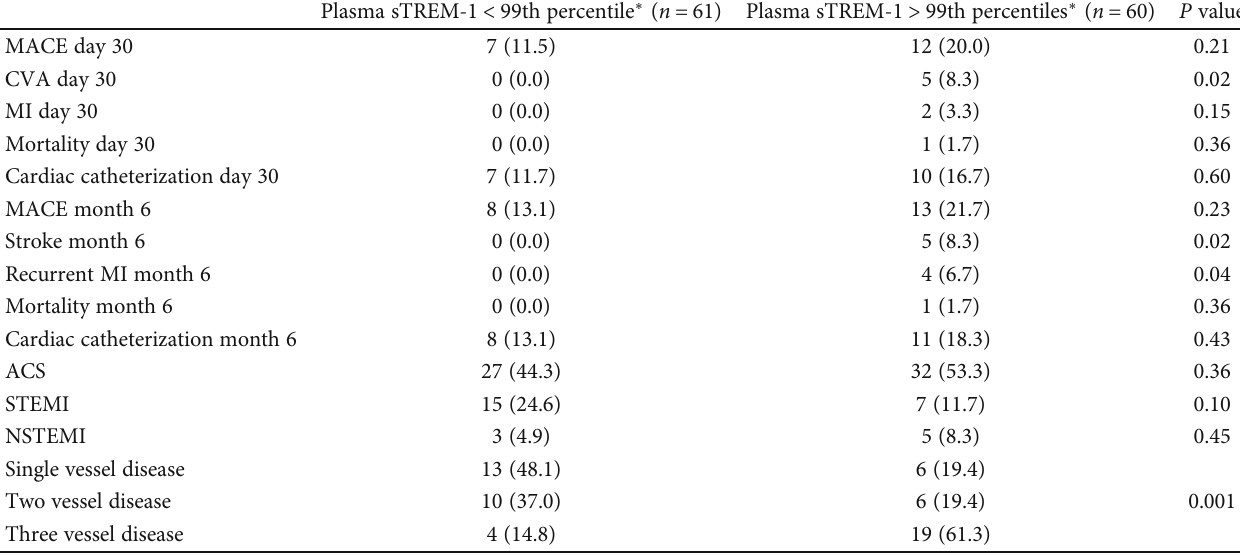
Table 3: Clinical outcomes in patients with plasma sTREM ‐ 1 < 99th percentile vs. patients with plasma sTREM ‐ 1 > 99th percentiles.